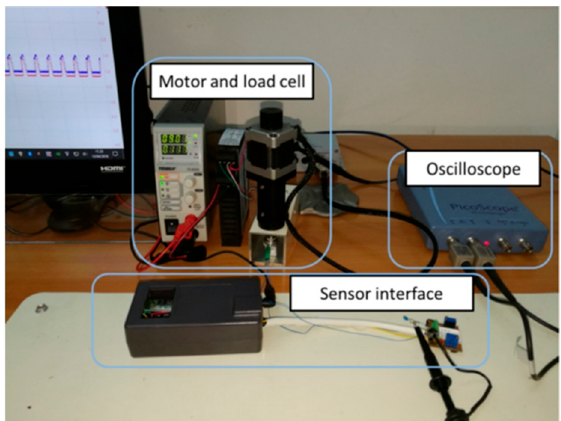
Figure 3. Measurement Set-up for IEE CP151 force resistive sensors calibration.